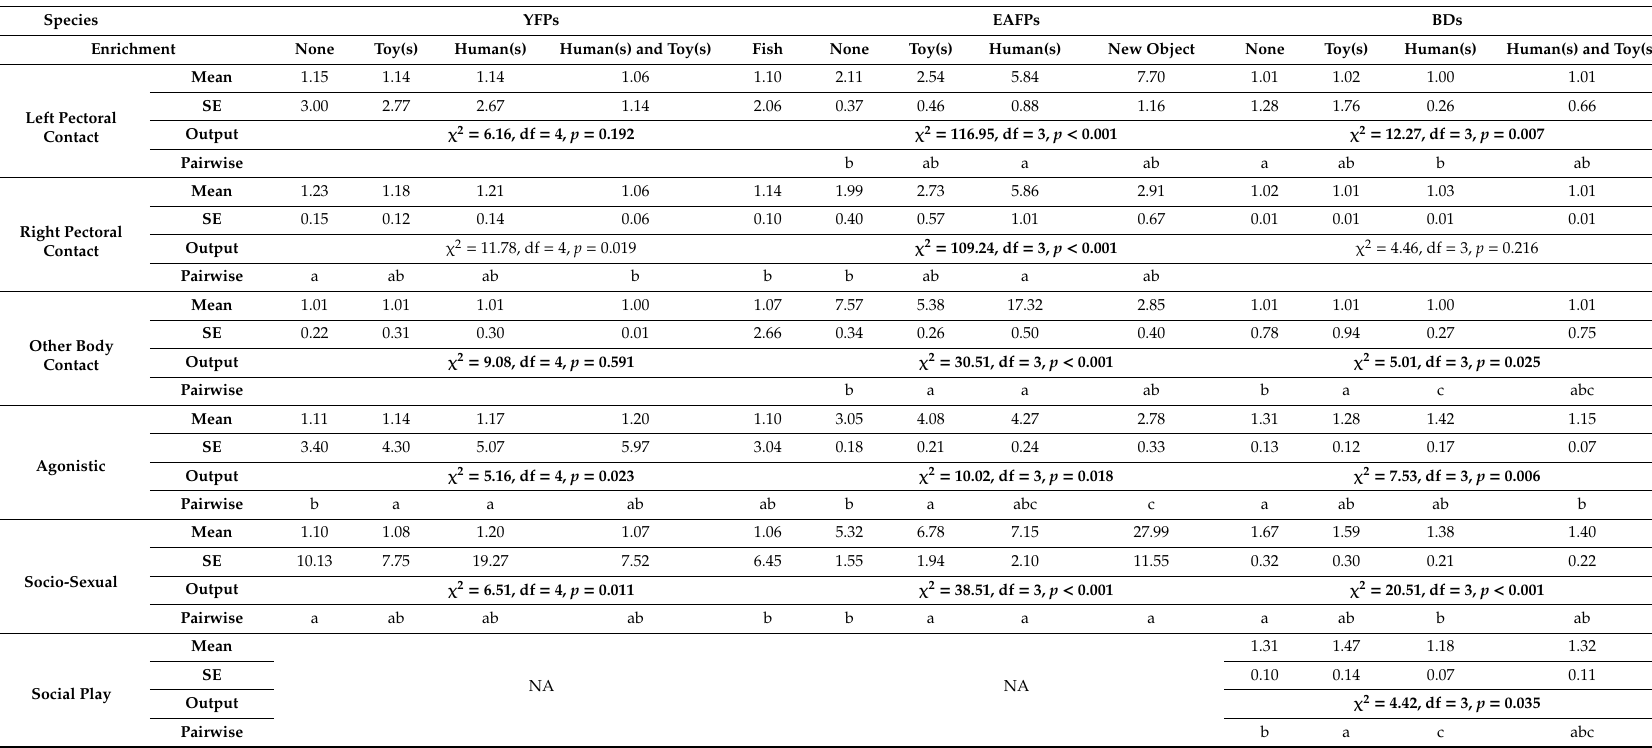
Table 7. Fitted means and standard errors of the frequency of each social behaviour depending on enrichment for Yangtze finless porpoises (YFPs), East-Asian finless porpoises (EAFPs) and bottlenose dolphins (BDs). Outputs come from Wald chi-squared tests run on Generalized linear mixed models, significant outputs are bolded. For each species and each behaviour, items sharing the same letter did not di ff er significantly, items that do not share the same letter di ff er significantly (post-hoc tests with sequential Bonferroni